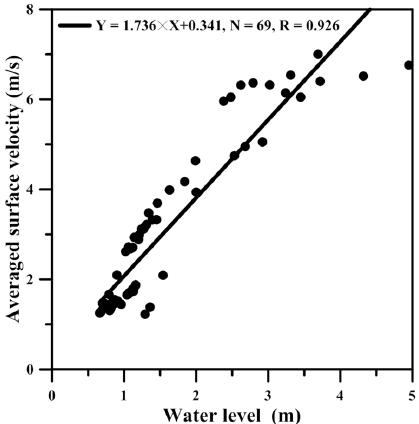
Figure 10. Scatter plot between measured water depths and averaged surface velocities for all typhoon events in 2015.